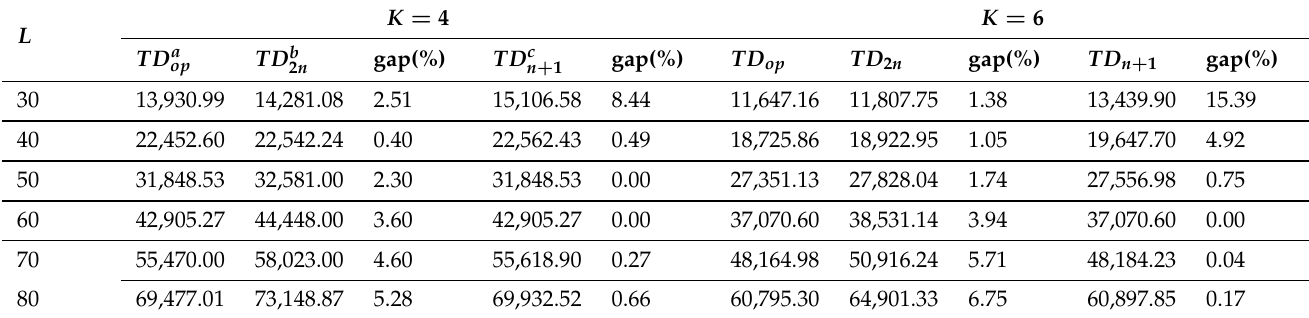
Table 8. Evaluation of two rules for a flying-V layout with varying lengths and even workstation numbers.